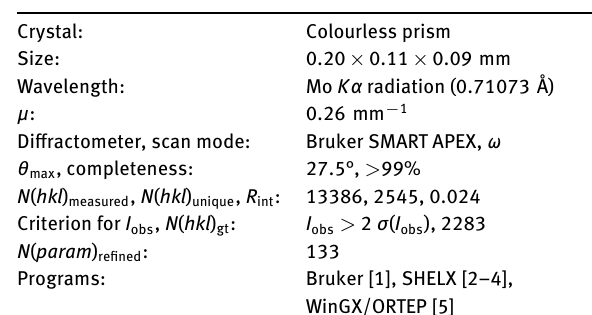
Table 1: Data collection and handling.